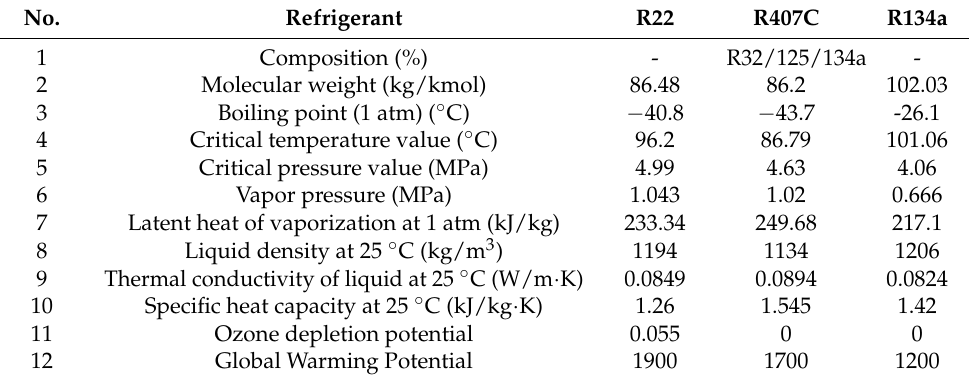
Table 15. Thermo-physical properties of R22, R407C and R134a [85].